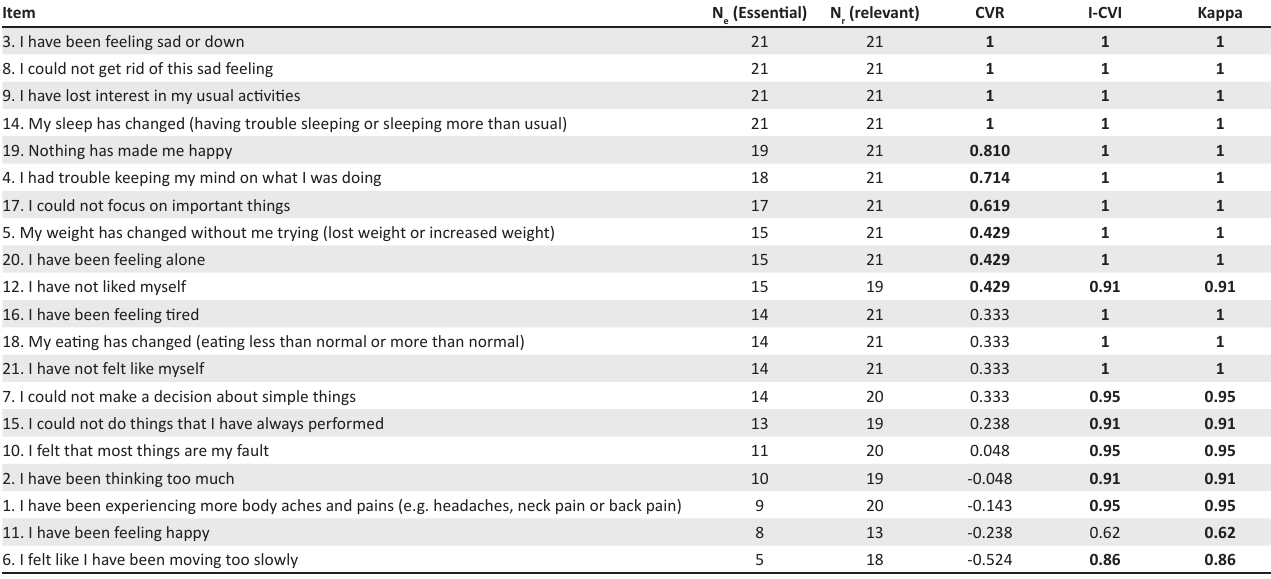
TABLE 4: Content validation statistics of study two.